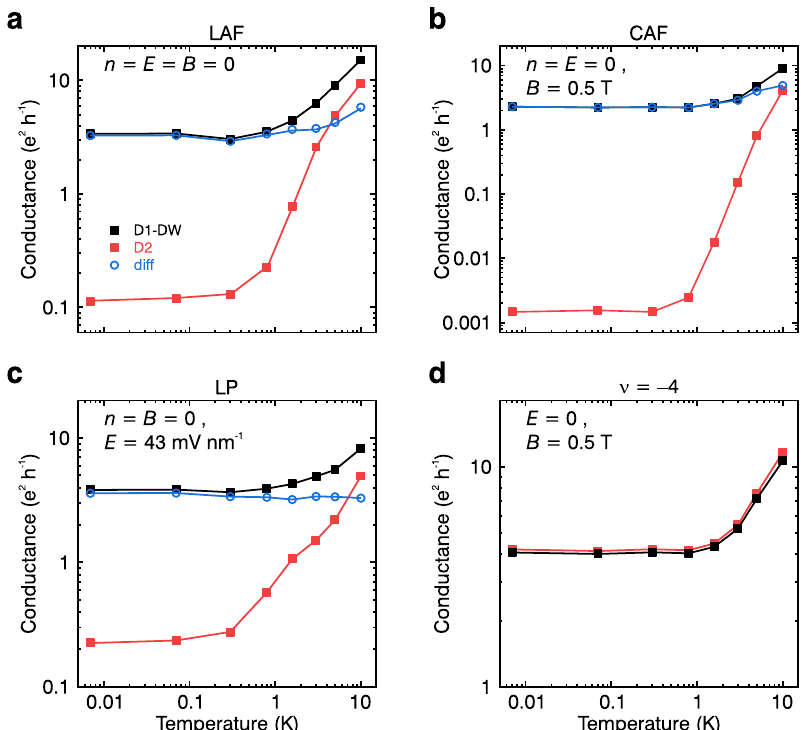
Fig. 4 Temperature dependence of the conductance in various broken-symmetry phases. a – d Temperature dependence of the conductance measured for the LAF phase at n = E = B = 0 ( a ), the CAF phase for n = E = 0 and B = 0.5 T ( b ), the LP phase at n = B = 0 and E = 43 mV nm − 1 ( c ) and the ν ¼ (cid:3) 4 phase at E = 0 and B = 0.5 T ( d ). The data corresponding to device D1-DW (D2) is shown in black (red). Moreover, in a – c , the difference of conductance T ð Þ (cid:3) σ ð T Þ is shown as a function of temperature in blue. Note that the temperature dependence was between the two devices σ diff T ð Þ ¼ σ D D 2 1 (cid:3) DW measured in a different loading and annealing cycle than the measurements shown in Figs. 1 – 3 leading to small disparities in the